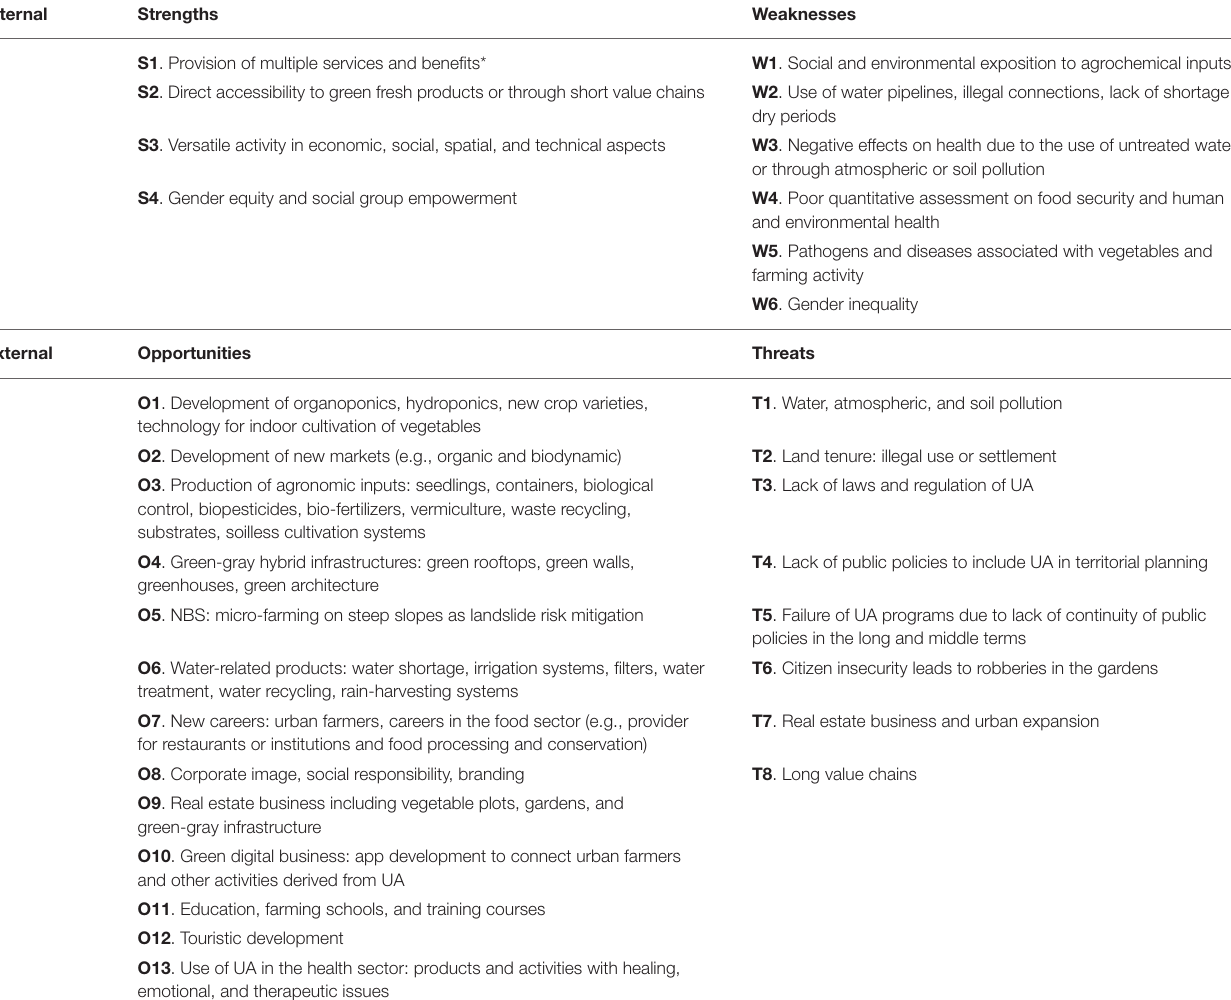
TABLE 2 | Strengths, weaknesses, opportunities, and threats of UA in